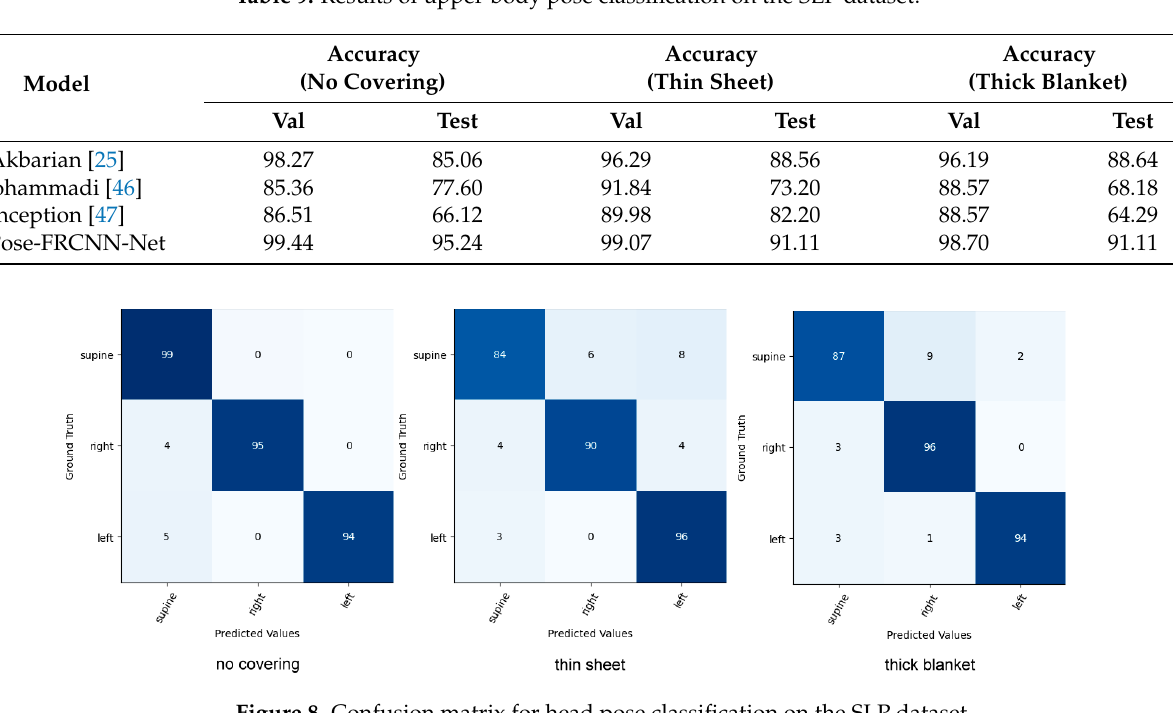
Figure 9. Confusion matrix for upper-body pose classification on the SLP dataset.